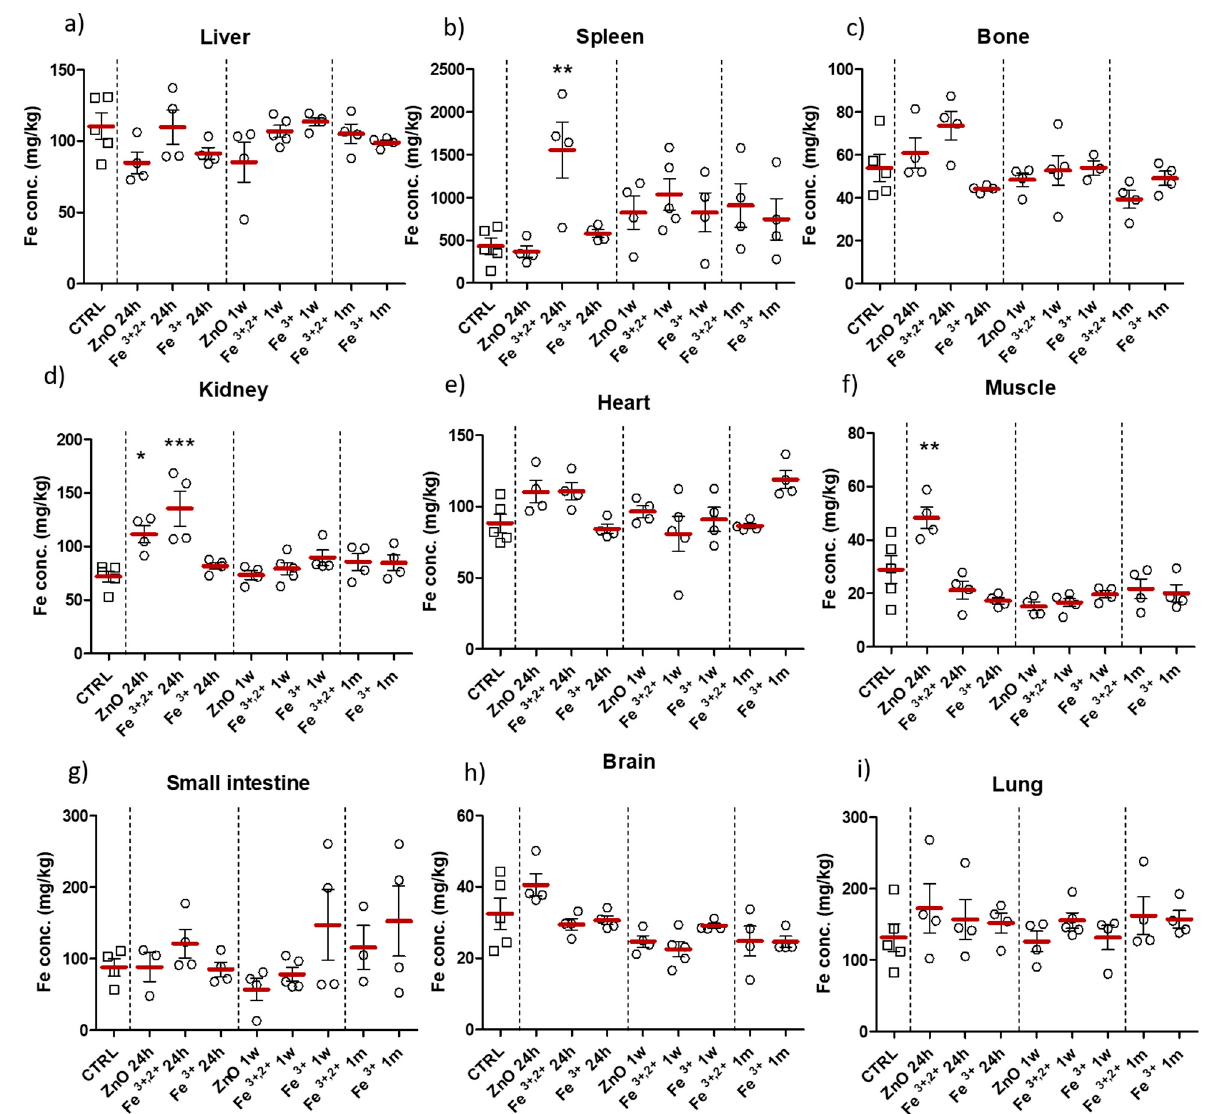
Figure 9. Tissue accumulation of iron in control group (CTRL) and after intra-gastric administration of ZnO, ZnO:Fe 3+ or ZnO:Fe 3+,2+ nanoparticles. Data represent mean level of iron concentration in tested organs (mg/kg of tissue), at different time following nanoparticle application (24 h, 1 w or 1 m). Data presented as mean ( ± SEM) for control ( n = 5) vs. experimental groups (ZnO 24 h n = 4; Fe 3+,2+ 24 h n = 4; Fe 3+ 24 h n = 4; ZnO 1 w n = 4; Fe 3+,2+ 1 w n = 5; Fe 3+ 1 w n = 4; Fe 3+,2+ 1 m n = 4; Fe 3+ 1 m n = 4). Statistically significant differences of * p ≤ 0.05, ** p ≤ 0.01, and *** p ≤ 0.001 were accordingly indicated. Range presented as squares for CTRL and circles for experimental groups.